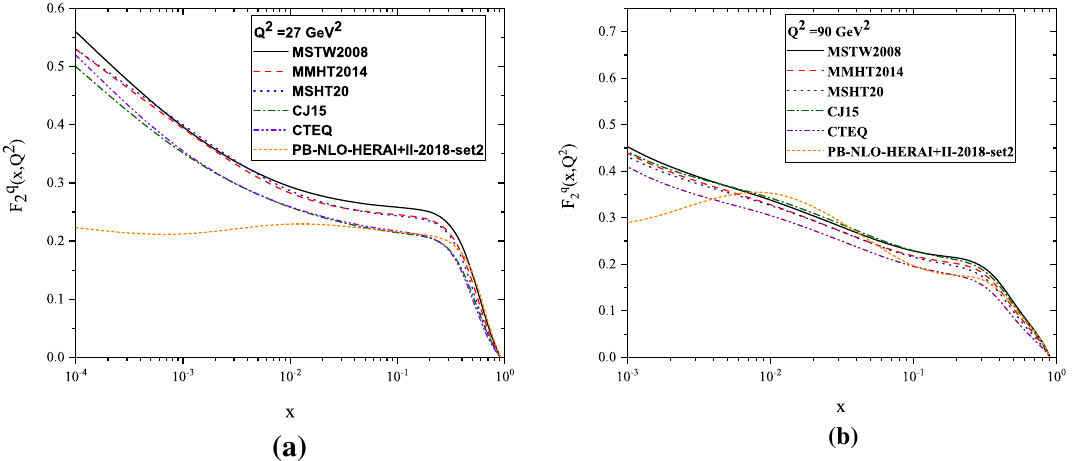
Fig. 10 The quark contribution to structure function of proton for numerous sets of PDF in the scale a Q 2 = 27 GeV 2 and b Q 2 = 90 GeV 2